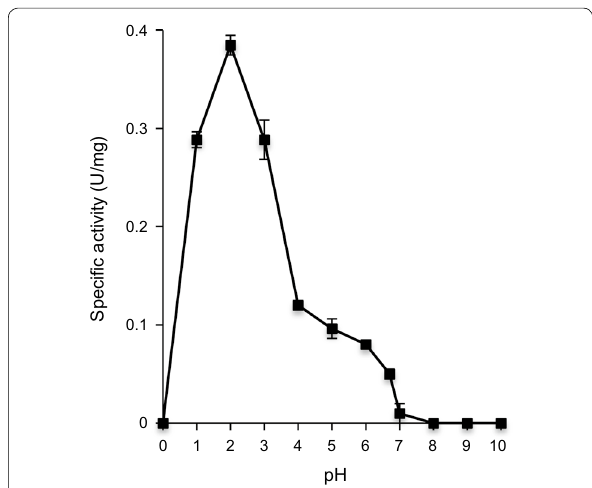
Fig. 6 Optimum pH for lignin peroxidase with n -propanol as substrate. The experiment was done in duplicate and the values are